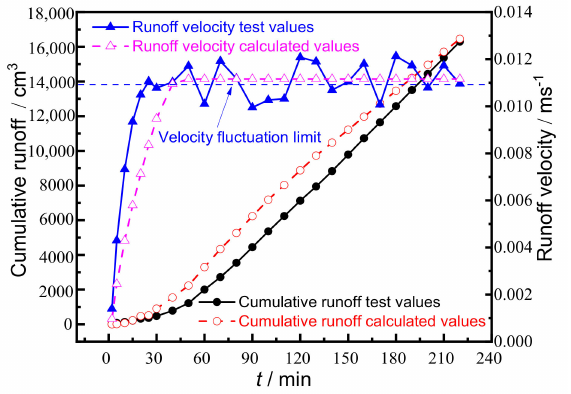
Figure 7. Comparison of cumulative runoff and runoff velocity.